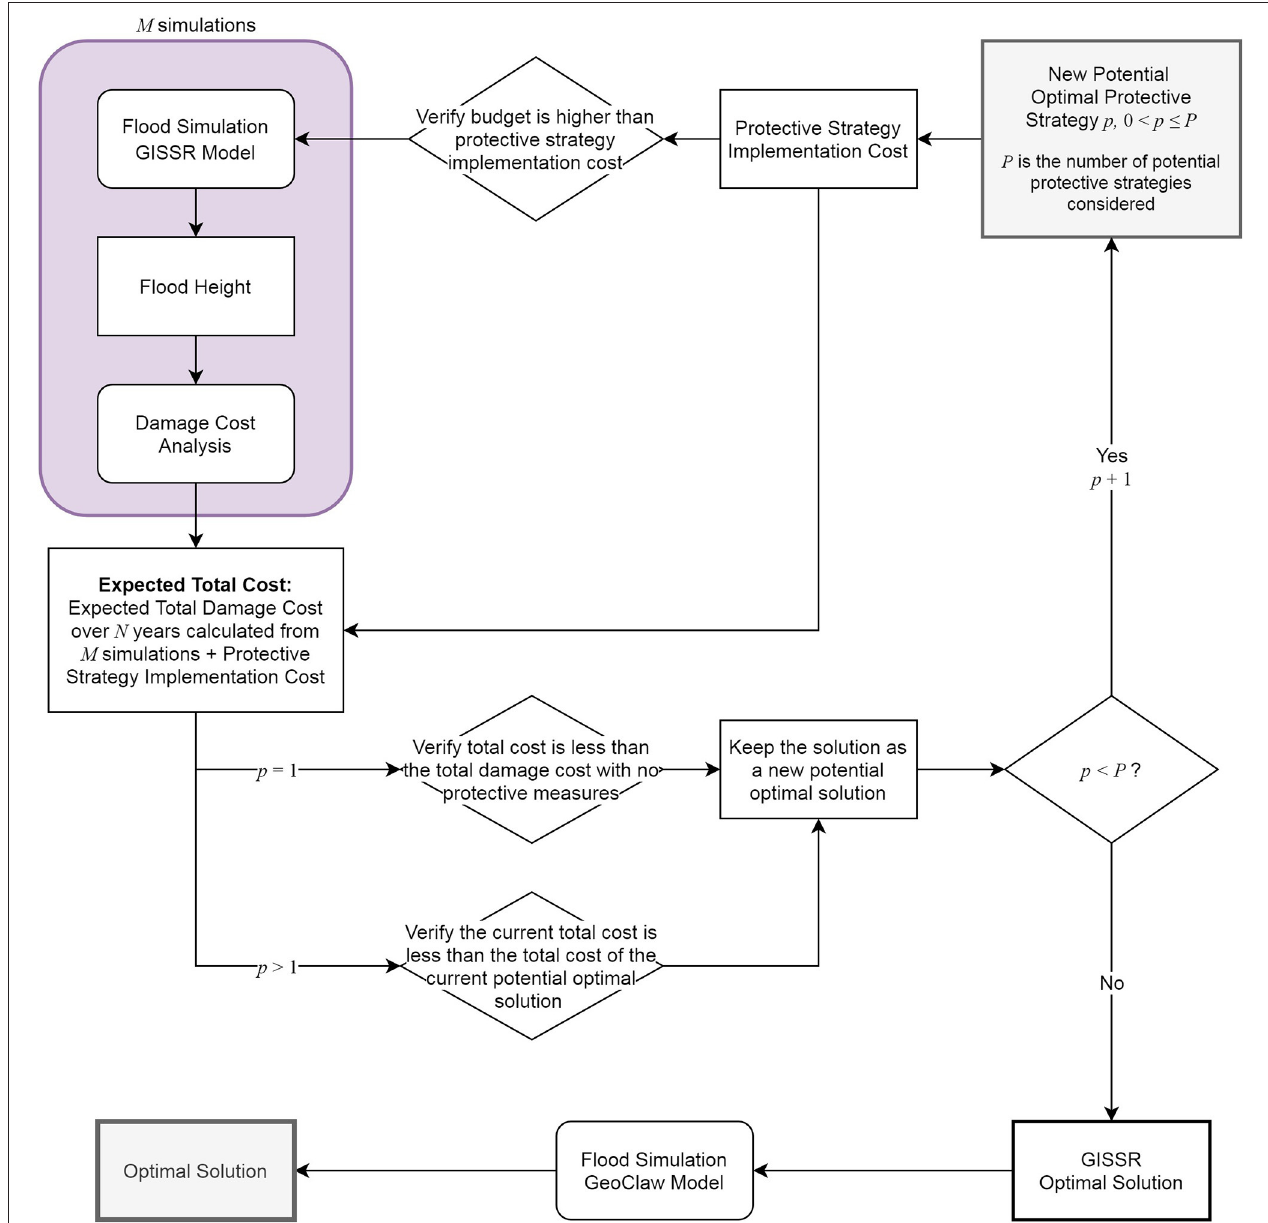
FIGURE 8 | Coastal protection optimization flow chart for the preliminary study considered in this paper. Rectangles indicate inputs and rounded rectangles indicate processes.